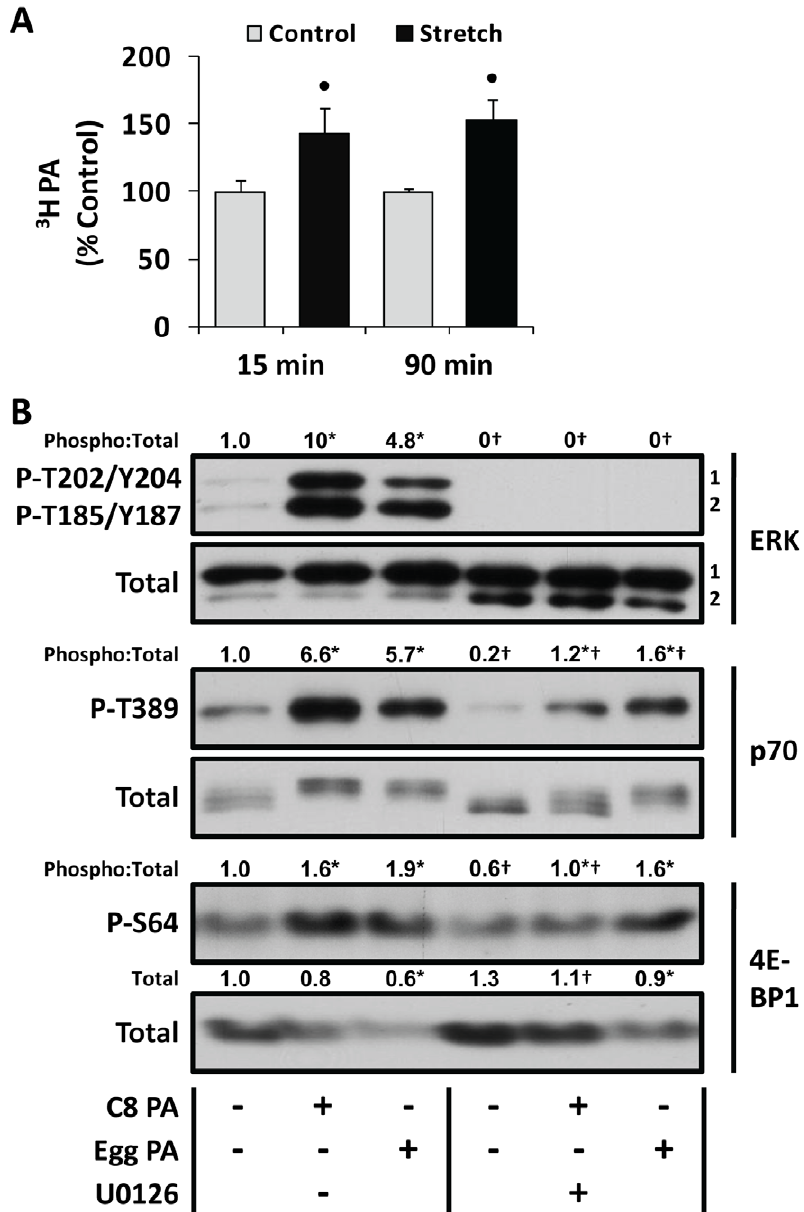
Figure 4. Exogenous phosphatidic acid activates mTOR signaling via an ERK-independent mechanism. ( A ) EDL muscles were held at Lo and pre-labeled with [ 3 H]-myristic acid for 2 h. The muscles were then subjected to 15 or 90 min of stretch or control conditions. Muscles were N collected at the end of the 15 or 90 min interval, and the amount of 3 H-labeled PA ( 3 H PA) was measured and then expressed as a percentage of Significantly different from the time-matched time-matched control values. The values are presented as the mean + SEM (n=4 2 7 per group). control group. ( B ) C2C12 myoblasts were serum-starved overnight and then pre-incubated with 50 m M U0126 (U0126 + ) or the vehicle (U0126 –, DMSO) for 30 min, followed by 20 min stimulation with 30 m M C8 PA, 300 m M Egg PA or the vehicle (Control, PBS). The samples were then subjected to western blot analysis for phosphorylated (P) and total ERK, p70, and 4E-BP1. The total amount, and phospho:total ratios, of each protein were measured and then expressed relative to the values obtained in the vehicle control samples (U0126 –, PBS). All values are presented as the mean and were obtained from three independent experiments (n=3 2 5 per group). *Significantly different from the drug-matched control group, { Significantly different from the stimulation-matched vehicle group, P #